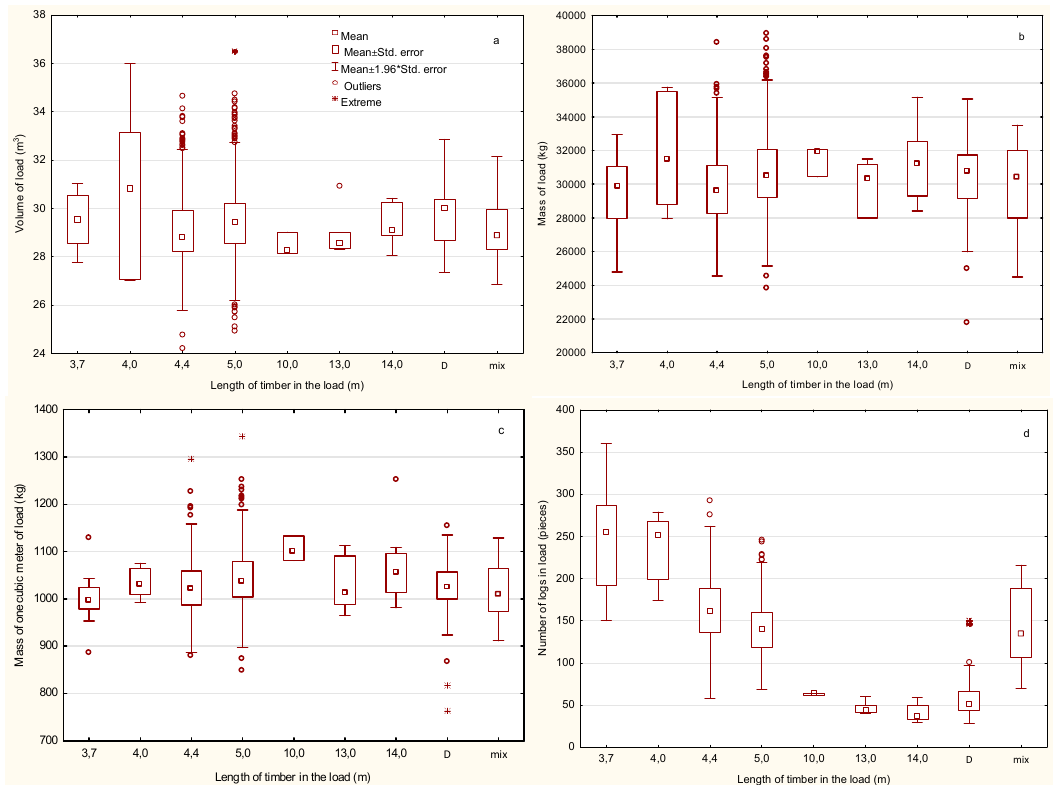
Figure 1. Comparison of average values characterizing timber loads depending on the length of the transported timber. ( a ) load volume, ( b ) load mass, ( c ) mass of 1 m 3 , ( d ) number of logs (pieces). D—tree-length logs; mix—load of mixed sawlogs and tree-length logs.